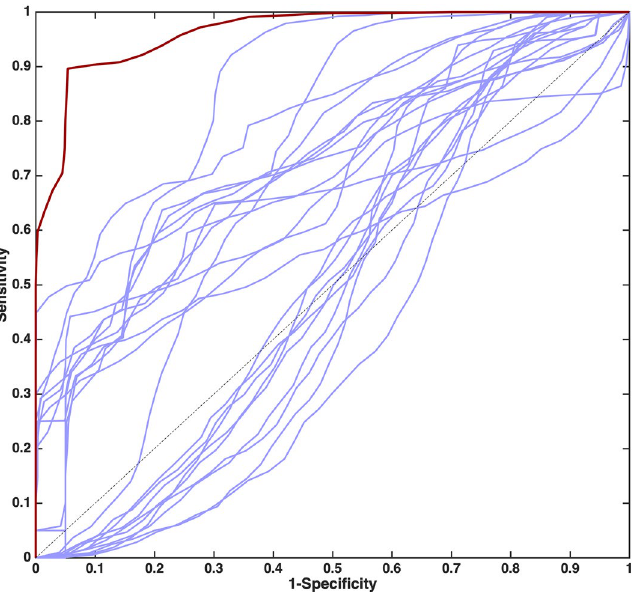
Figure 3. Receiver operating characteristic (ROC) curve for the PLS-DA model calculated on the ESI + data set (dark red line) and for the individual metabolites (blue lines). Each curve is the mean of the 50 curves obtained on the outer loop samples in r-dCV.